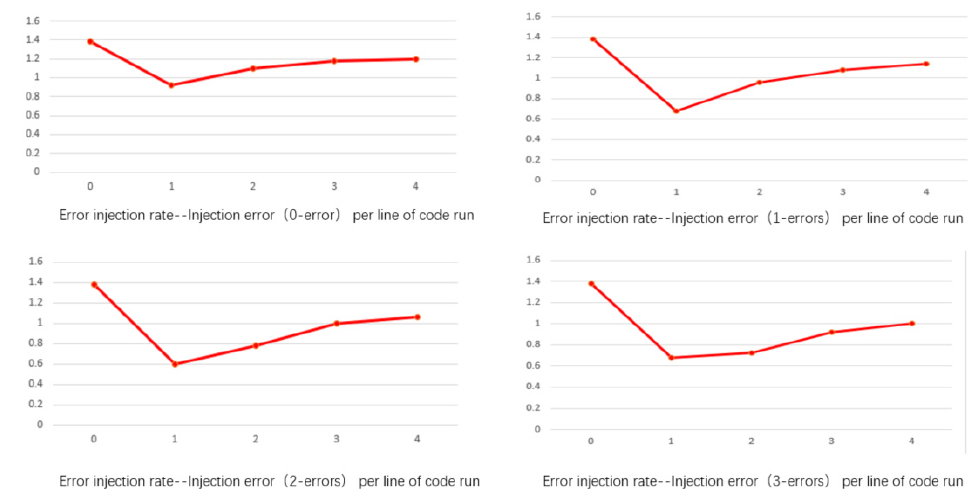
Figure 31. Dhrystone running scores under different error injection frequencies.